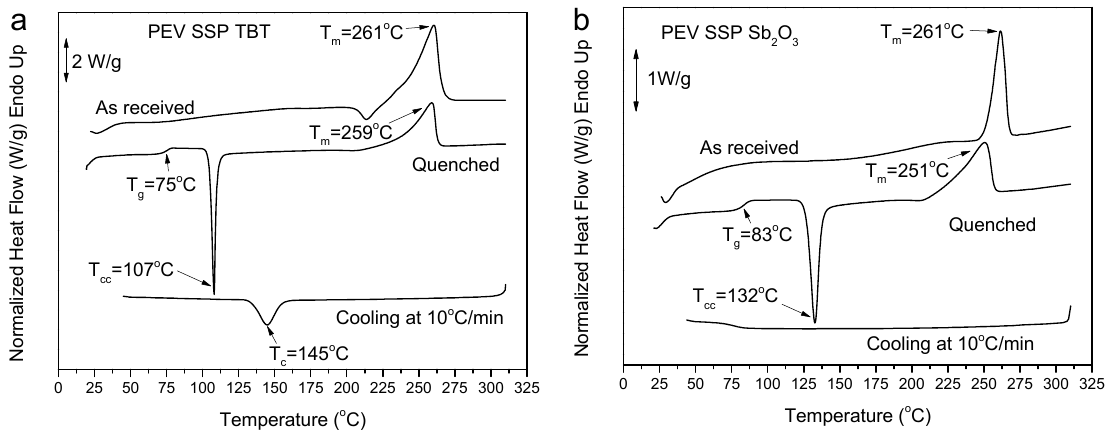
Figure 3. Differential scanning calorimetry (DSC) scans for: ( a ) PEV prepared using TBT catalyst and ( b ) PEV prepared using Sb 2 O 3 catalyst.